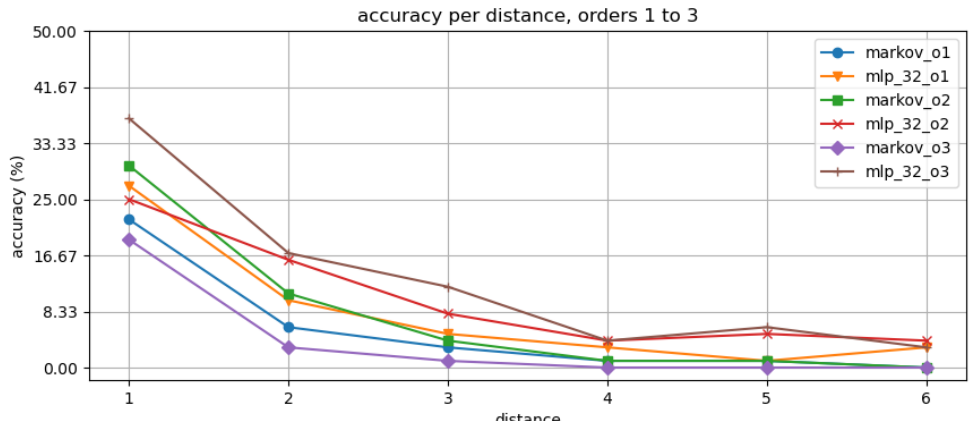
Figure 3. Accuracy related to the order of baseline models.